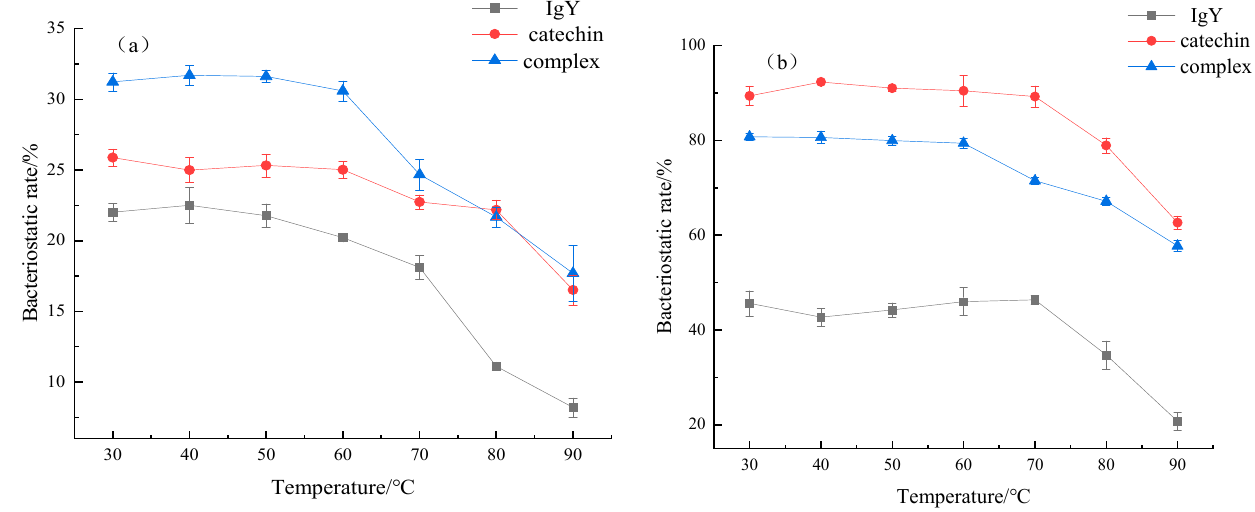
Figure 5. The effect of IgY interactions with catechins on antibacterial thermal stability of E. coli ( a ) and S. aureus ( b ).